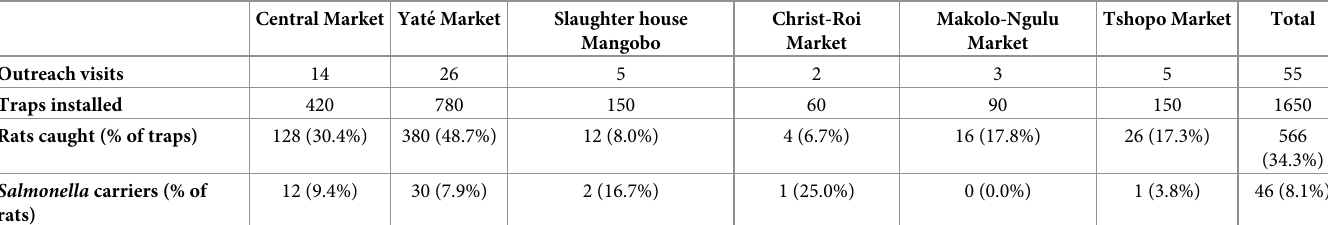
Table 1. Numbers of outreach visits, rats caught and Salmonella carriers over the six sampling sites in Kisangani 2016–2018. Central Market Yate´ Market